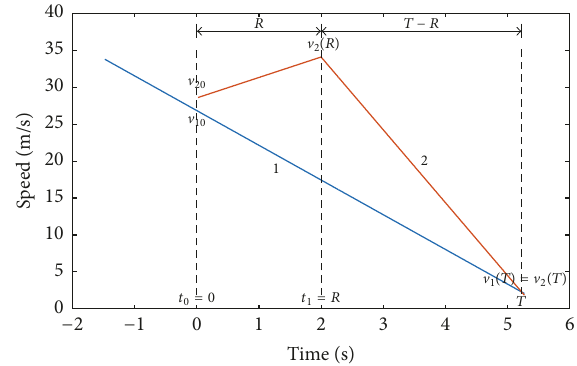
Figure 1: Distance-time diagram of the conflict situation. The trajectories of the leading and following vehicle are labeled with the numbers 1 and 2, respectively. The considered time period for the indicator starts at the initial time 𝑡 0 = 0 with a reaction of the following vehicle at time 𝑡 1 = 𝑅 .